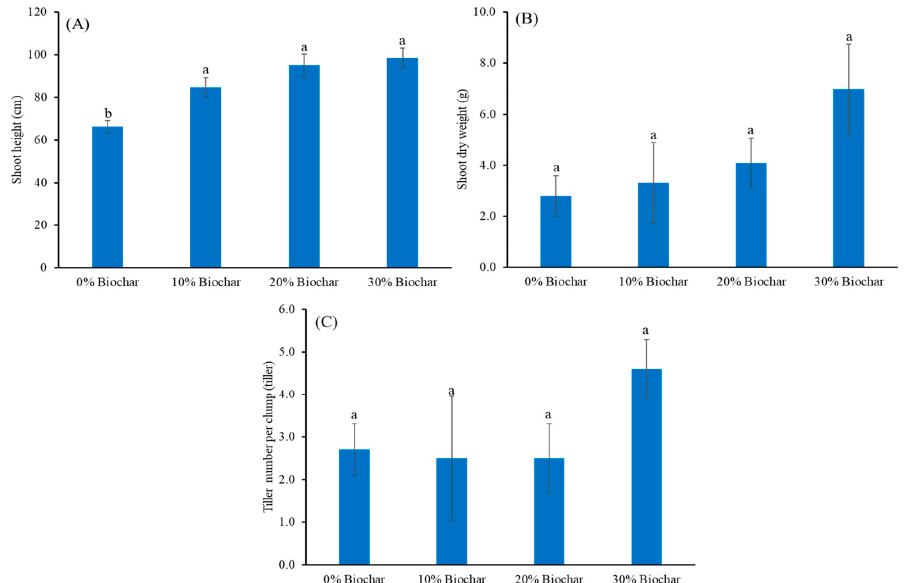
Figure 3. Shoot height ( A ), shoot dry weight ( B ), and number of tillers per clump ( C ) for Phitsanulok 2 rice grown in saline soil with different rates of biochar application in Yoshida solution. Data are means ± SE (n = 3). Bars with different letters are significantly different at p < 0.05 according to DMRT.